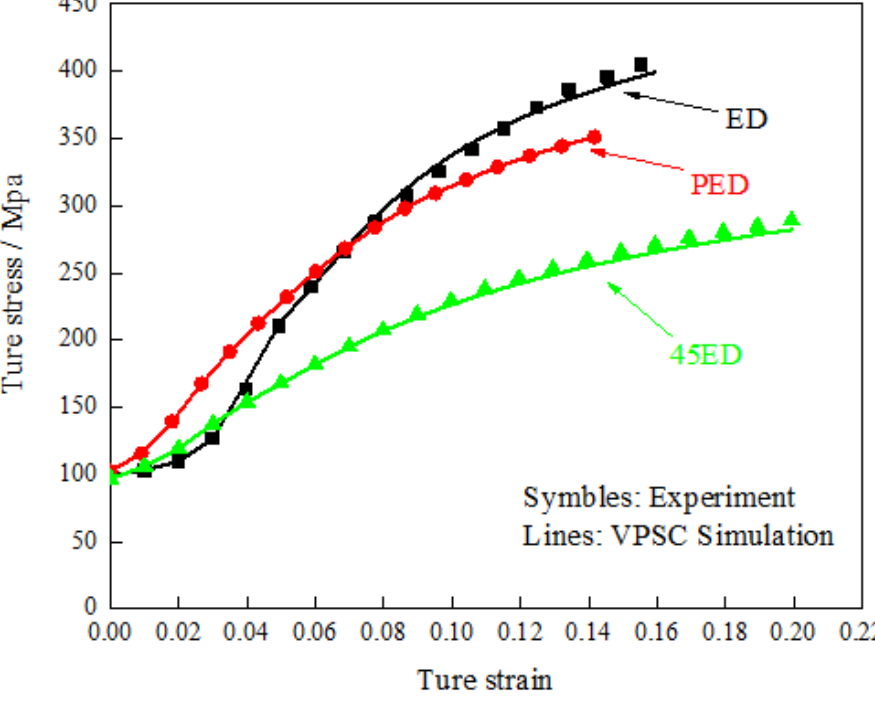
Figure 2. Experimental (symbols) and simulated (lines) true stress–strain curves of various AZ31 alloys samples under uniaxial compression. Table 1. Voce hardening parameters inputs for the VPSC modeling (unit: MPa).